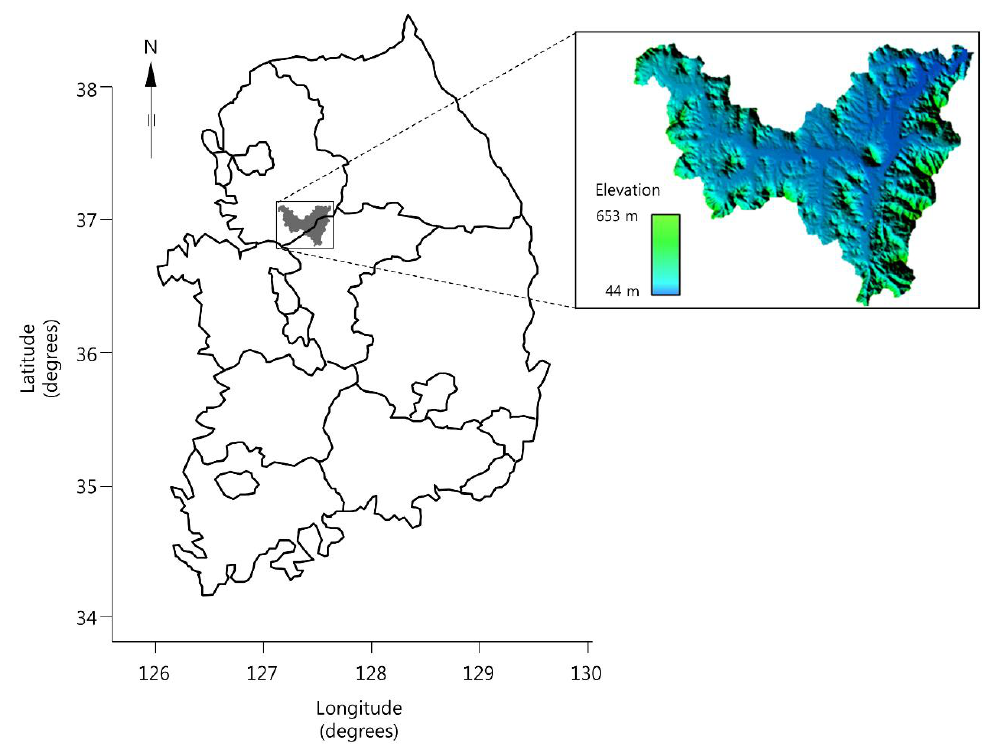
Figure 1. Cheongmi-cheon watershed. Center is approximately 127.52° E, 37.67° N, which is about 70 km south east of Seoul, Korea.